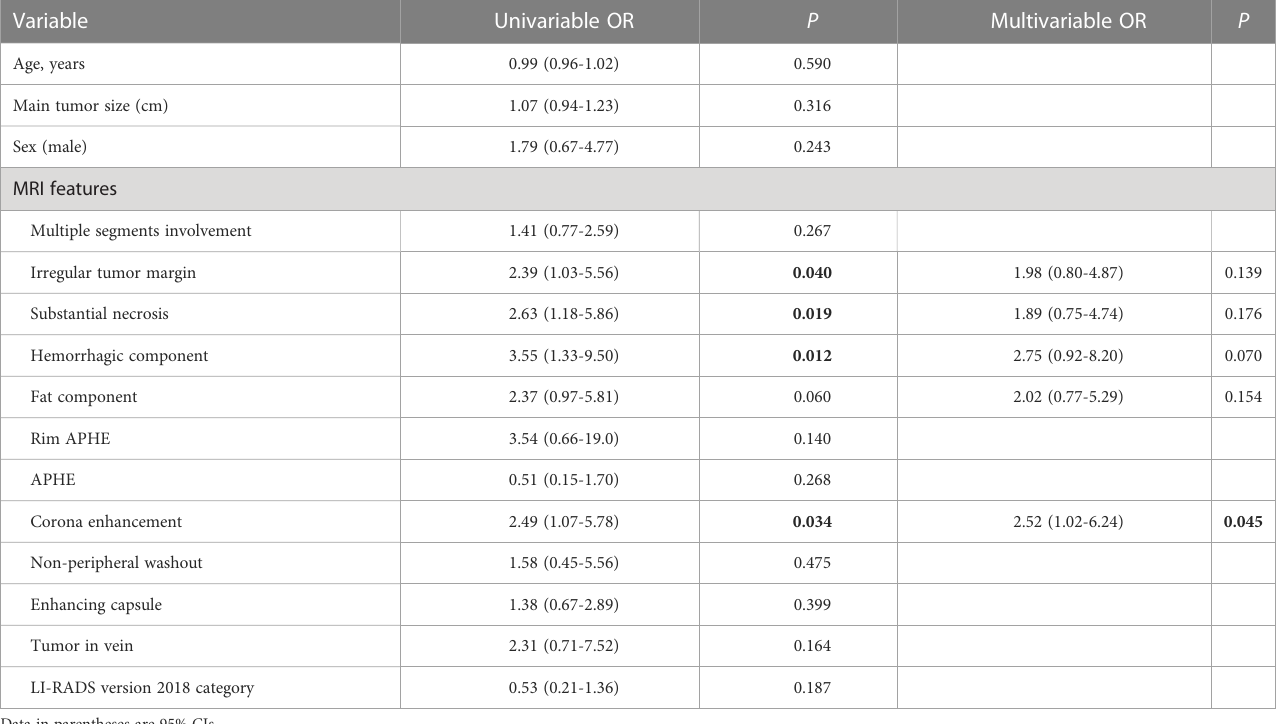
TABLE 4 Predictors for macrotrabecular-massive subtypeby of hcc in the primary cohort by logistic regression analysis.